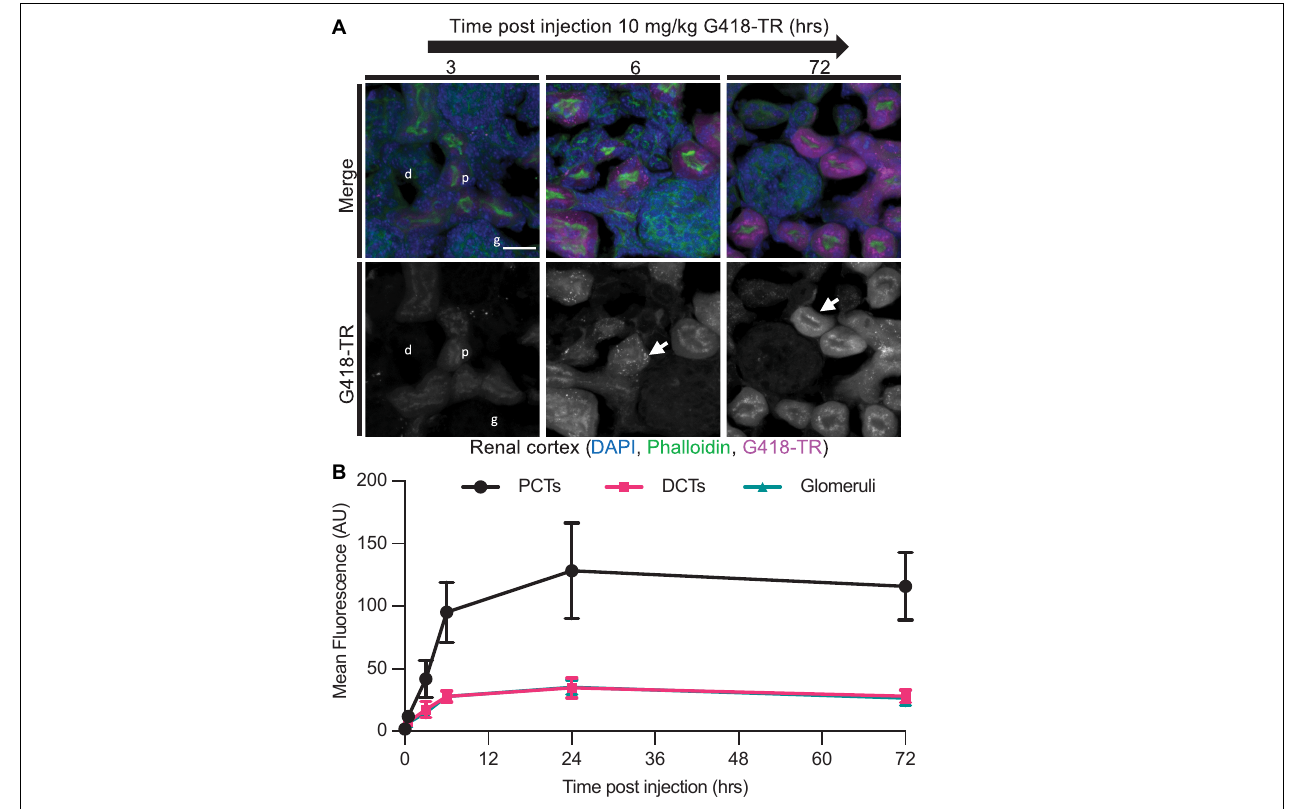
FIGURE 5 | Selective aminoglycoside retention in proximal convoluted tubule cells of the kidney. (A) 0 min–72 h after systemic injection with G418-TR, neonatal mice (P5) were sacrificed, and kidneys were removed. Tissues were fixed, embedded and cryostat sectioned at a thickness of 12 µ m. Tissue sections were stained with phalloidin and DAPI. Representative maximum projection images from the renal cortex show proximal convoluted tubule (p) uptake and retention, but minimal uptake in the distal convoluted tubule (d) and glomeruli (g). Like hair cells, PCT cells also show apical puncta (arrow) accumulation of G418-TR. Scale bar = 20 µ m. (B) Mean fluorescence from proximal convoluted tubules (PCTs), distal convoluted tubules (DCTs), and glomeruli was calculated over 72 h. PCTs demonstrate G418-TR uptake and retention like that observed in cochlear hair cells. Animals examined n = 4 for each time point. Error bars are standard deviations. AU, arbitrary